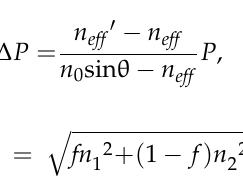
Figure 1. 2D schematics of the uniform ( a ) and apodized ( b ) grating couplers for the silicon HPWs with a bottom metal layer. ( c ) Simulated transmission spectra of them with optimal structures.